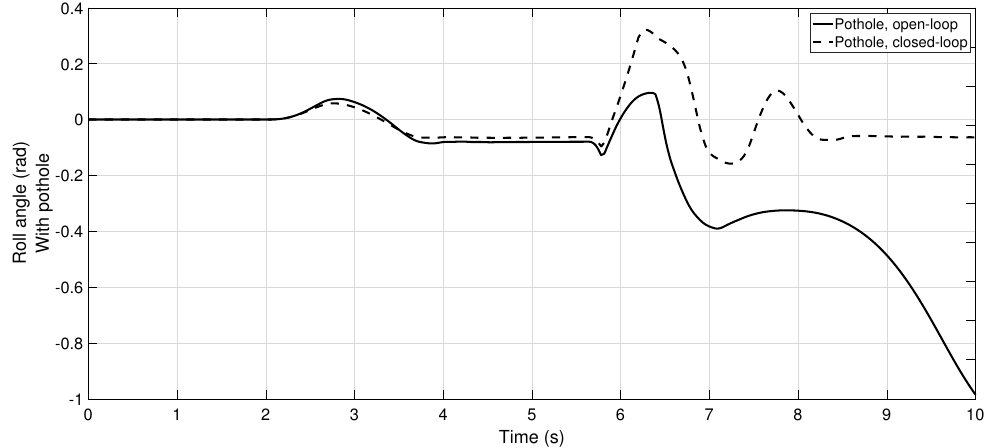
Figure 13. Comparative of the roll angle for open and closed-loop, with a pothole in the rear left wheel ( − 0.15 at 5.6 s), for the maneuver of Figure 2a augmented by 300%. Also, µ = 0.6, l f = 0.882 m, l r = 1.143 m, h = 0.432 m, b r = 0.625 m, bl = 0.425 m and m = 597 kg. In open-loop the vehicle suffers a rollover with the pothole. In closed-loop the rollover is mitigated despite wheels lifting. See video animations.